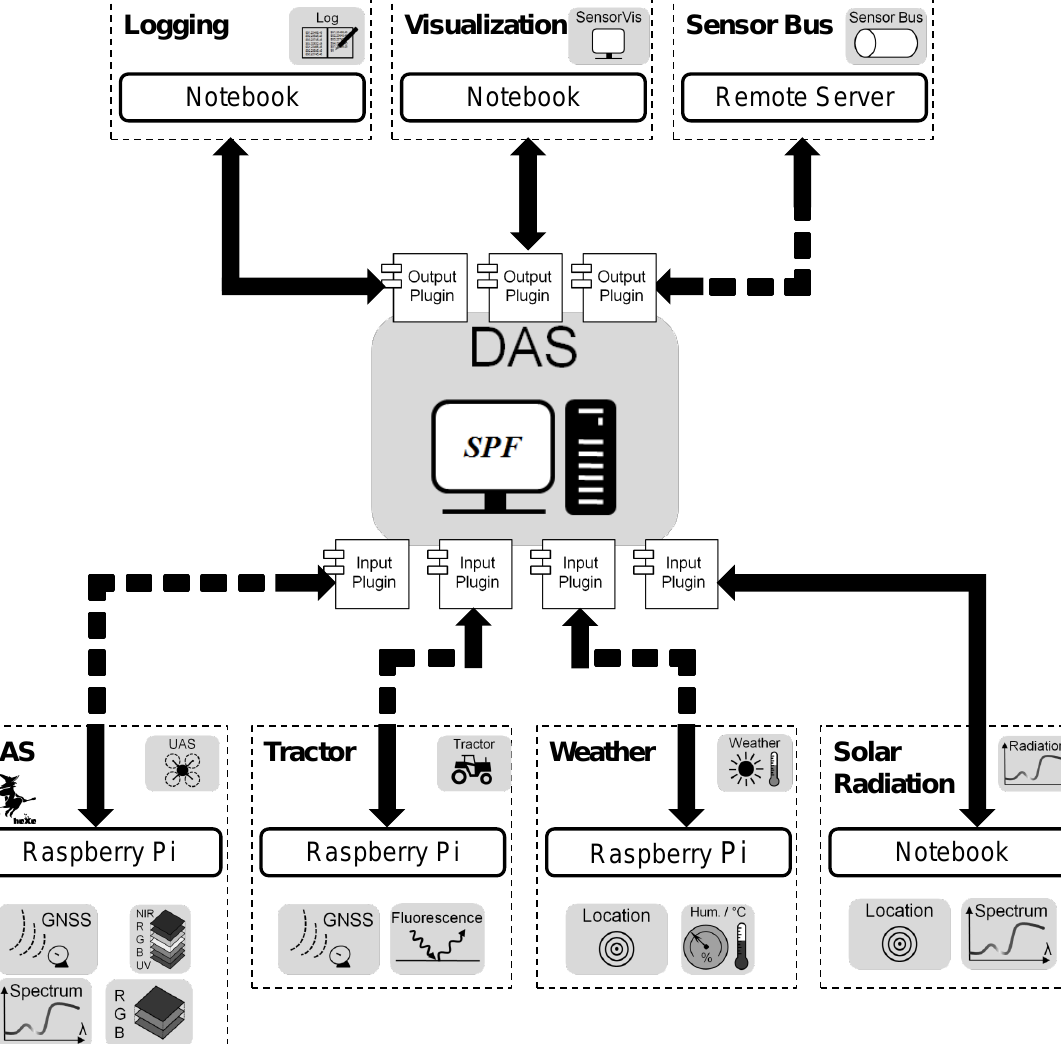
Figure 3. Overview of the input and output plugin architecture of the Sensor Platform Framework (SPF), which serves as the data acquisition system (DAS). Four input plugins were implemented to control and access all sensor systems individually. The Raspberry Pis and the notebook serve as control units, implementing vendor-specific sensor protocols. DAS and control units communicate with each other either through wireless (dashed lines) or wired connections (solid lines). Three output plugins were implemented for: (i) the live-visualization of sensor observations during measurement; (ii) for the local logging of received sensor data; and (iii) for the forwarding of the sensor data into the sensor bus. Visualization and logging were performed on the notebook, running the DAS. Forwarding data into the sensor bus was realized via a mobile Internet